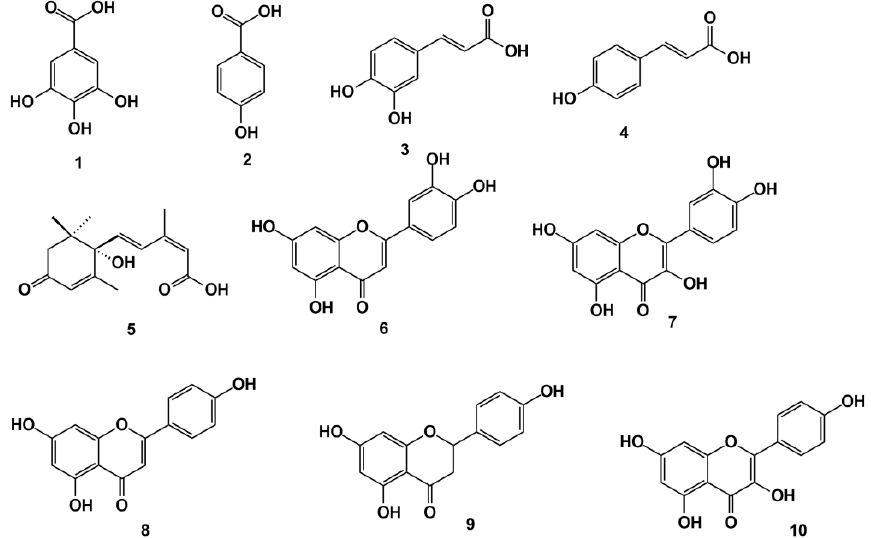
Figure 11. Phenols identified in the phenol fraction of E. officinarum honey from Morocco.